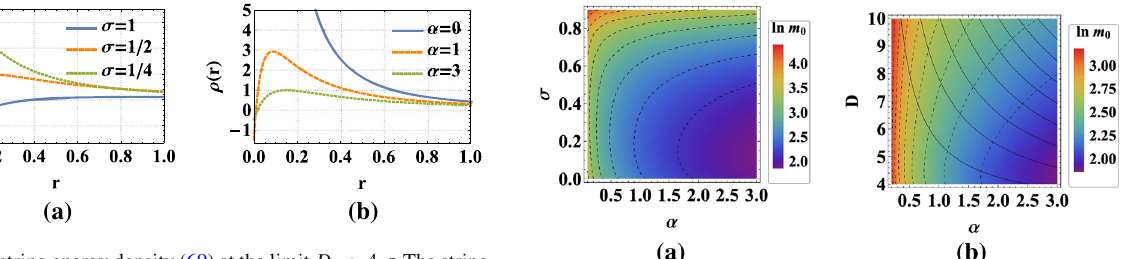
density in Fig. 9, from which one finds that the mass density decreases with the increasing of σ or α . Each dashed curve in Fig. 9a labels the cosmic strings with the same mass